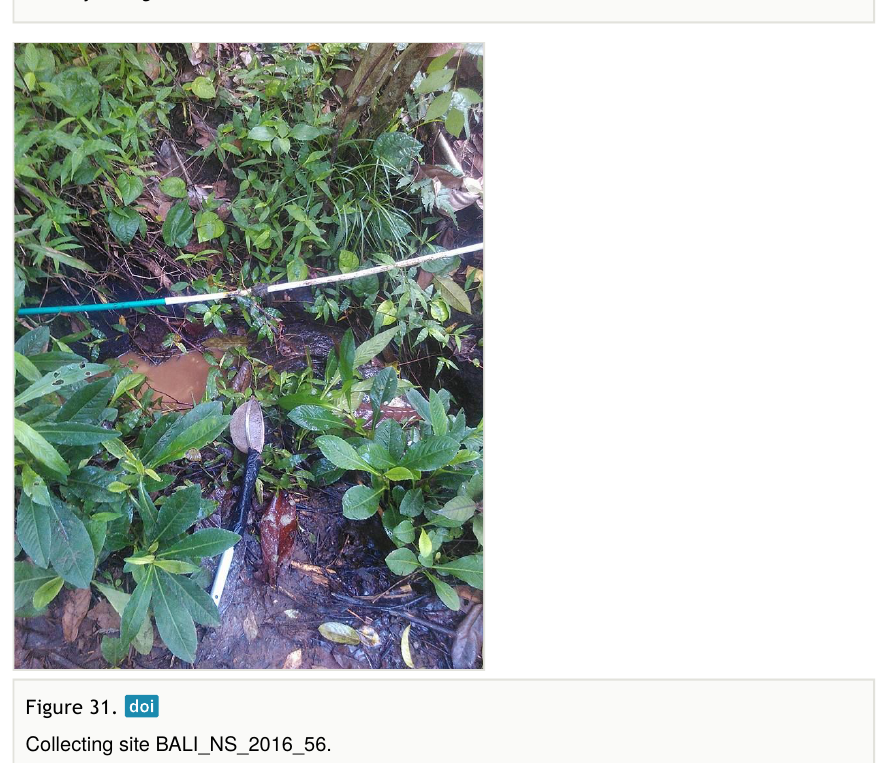
Figure 30. Microdytes elgae Distribution in Bali.